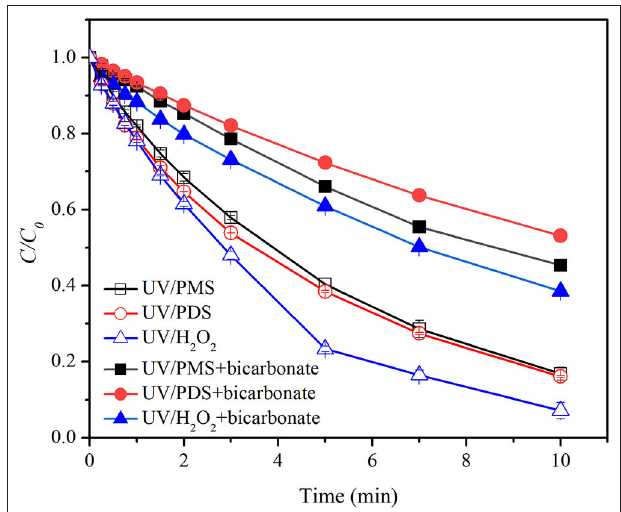
FIGURE 2 | Degradation efficiencies of BA by UV/PMS, UV/PDS, and UV/H 2 O 2 in the presence of bicarbonate. Conditions: 0.6L, I 0 = 1.7 × 10 − 6 Einsteins · s − 1 , [PB] = 2mM, [BA] = 9.0 µ M, [PMS] = 100 µ M as 1/2 Oxone,